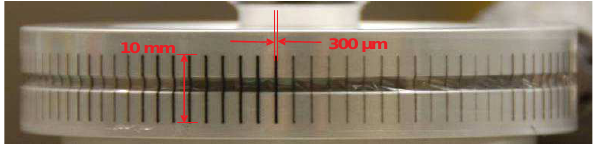
Fig. 1. RDI sampling drum: a notched aluminum wheel, coated with a 6-µm PP film, used for sampling and subsequent SR-XRF- analysis as well as for the calibration. The bar code-like structure of deposited particulate matter is visible on the film. The black color on the depicted stage 1 bars with a width of 300µm and a height of 10mm is mainly caused by soot